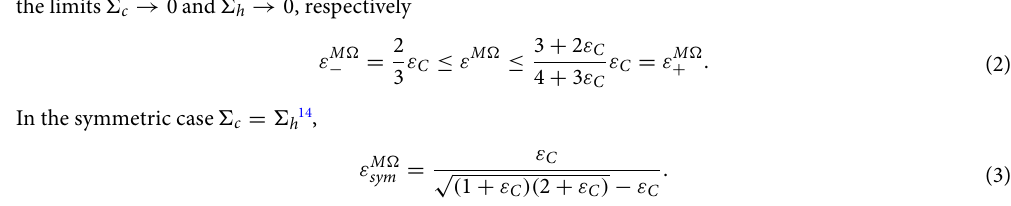
The (cid:31) function was proposed for a generic heat device as a trade-off figure of merit between the maximum useful energy and the unavoidable useful energy losses for a given energy input. For a RE, it is defined as the Q c / t , and lost cooling rate for a fixed power input, P in . Then, compromise between maximum cooling rate, R = the (cid:31) function is 14